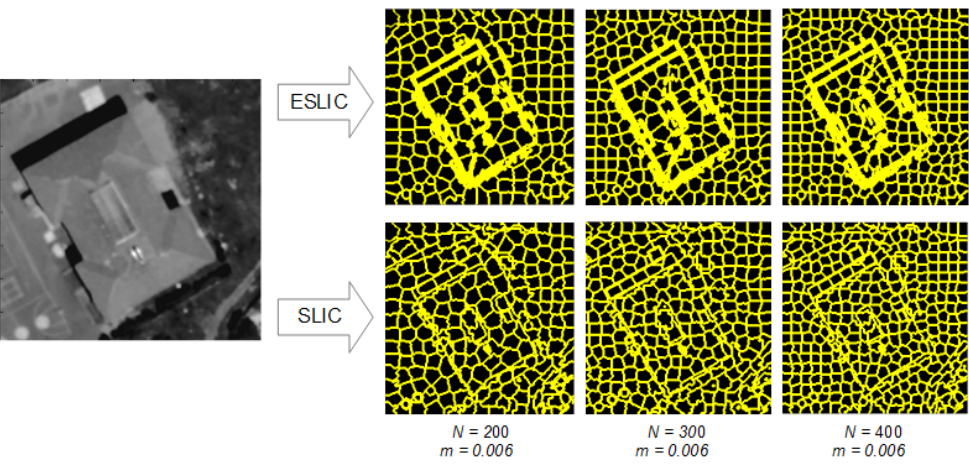
Figure 12. ESLIC results ( top ), vs. SLIC superpixels ( bottom ), both for the same scales. ESLIC can preserve boundaries and main ridge lines regardless of the